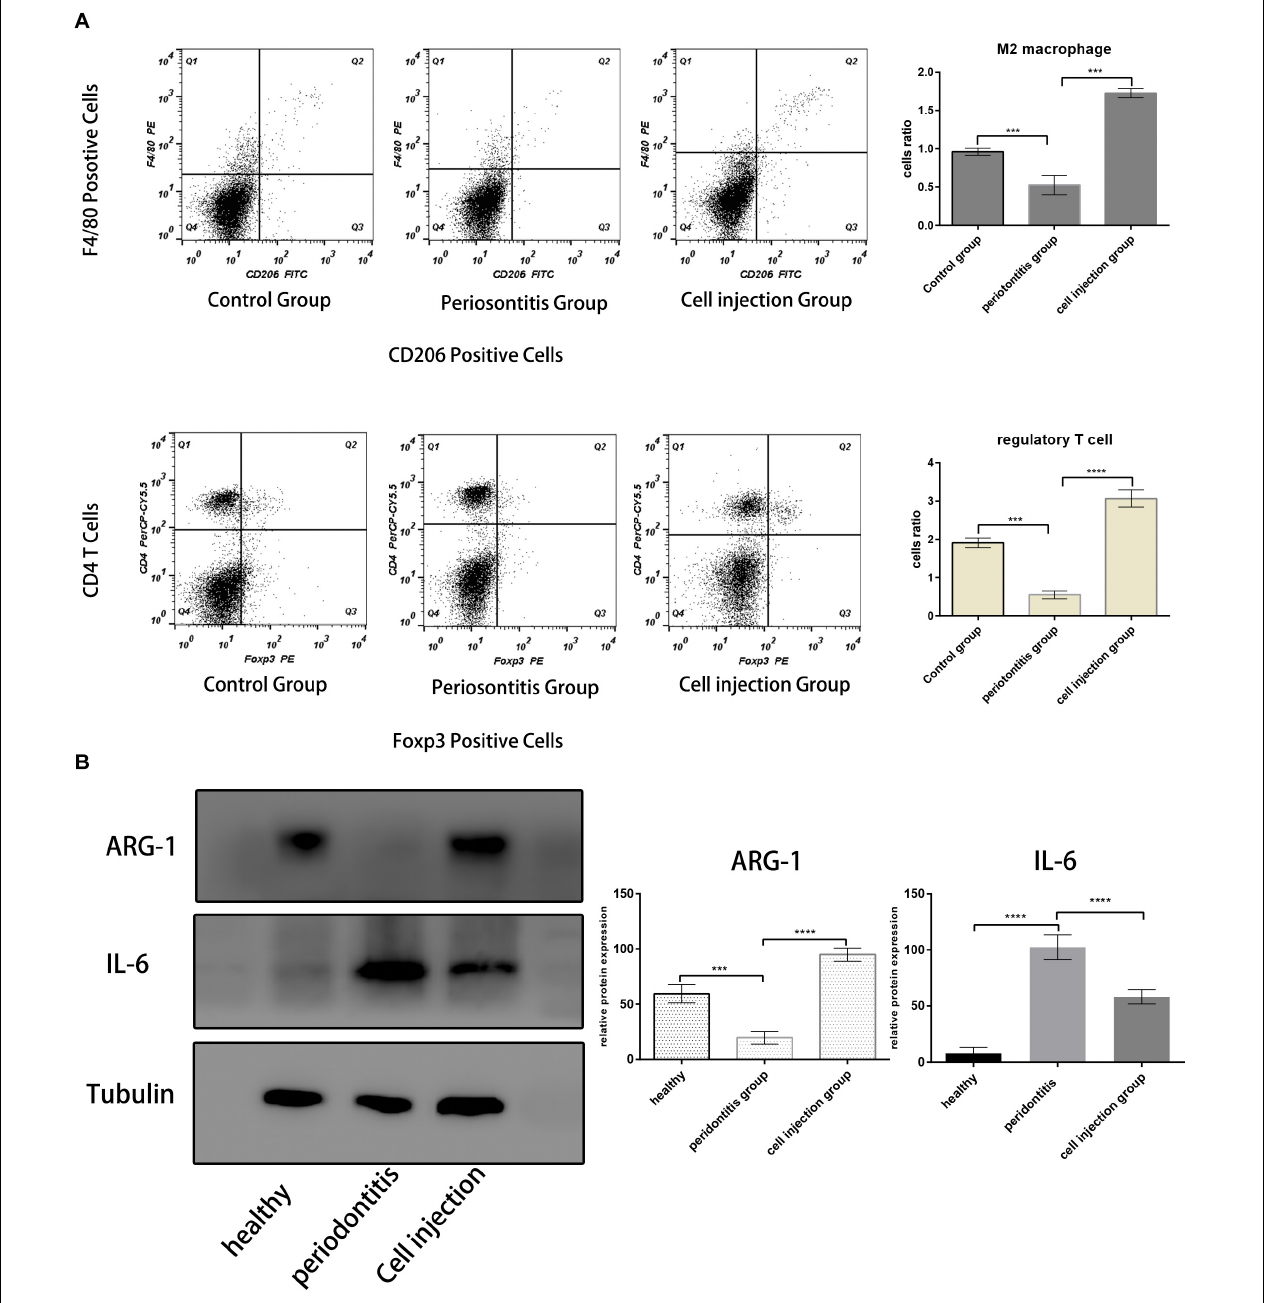
FIGURE 3 | M2 macrophages and regulatory T cell population analysis. (A,B) Flow cytometric analysis of cells in the mice periodontal tissue in each group. The M2 macrophages were gated with F4/80 + and CD206 + ; the Treg cells were gated with CD4 + and Foxp3 + . Both the ratios of F4/80 + and CD206 + cells and CD4 + and Foxp3 + cells are lower in the periodontitis group and higher in the healthy group and cell injection group. (C) Western blot analysis of IL-6 and ARG-1 protein in the gingival tissue. The statistical significance was determined by P -value (*** P < 0.001, **** P <